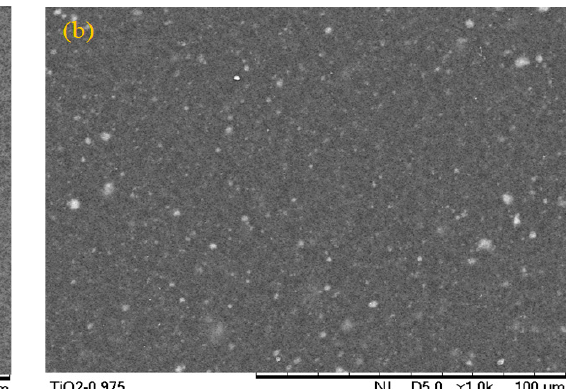
Figure 2. SEM images of membrane cross-sections: ( a ) pristine PVDF, ( b ) PVDF–TiO 2 , ( c ) PVDF–PEG, ( d ) PVDF–TiO 2 -PEG, ( e ) PVDF–PVP, ( f ) PVDF–TiO 2 -PVP. Top surface SEM micrographs of PVDF–TiO 2 MMMs are shown in Figure 3. Connected pores on the surface of all membranes were observed at magnifications of 1 k (see Figure 3). Identified TiO 2 nanoparticle dispersion in the synthesized membranes was consistent with the theory postulated by [39] which states that the thermodynamic stability of nanoparticles in a polymeric liquid is strongly correlated with the ratio of the linear polymer’s radius of gyration (Rg) to the radius of the nanoparticles (Rp) [8].